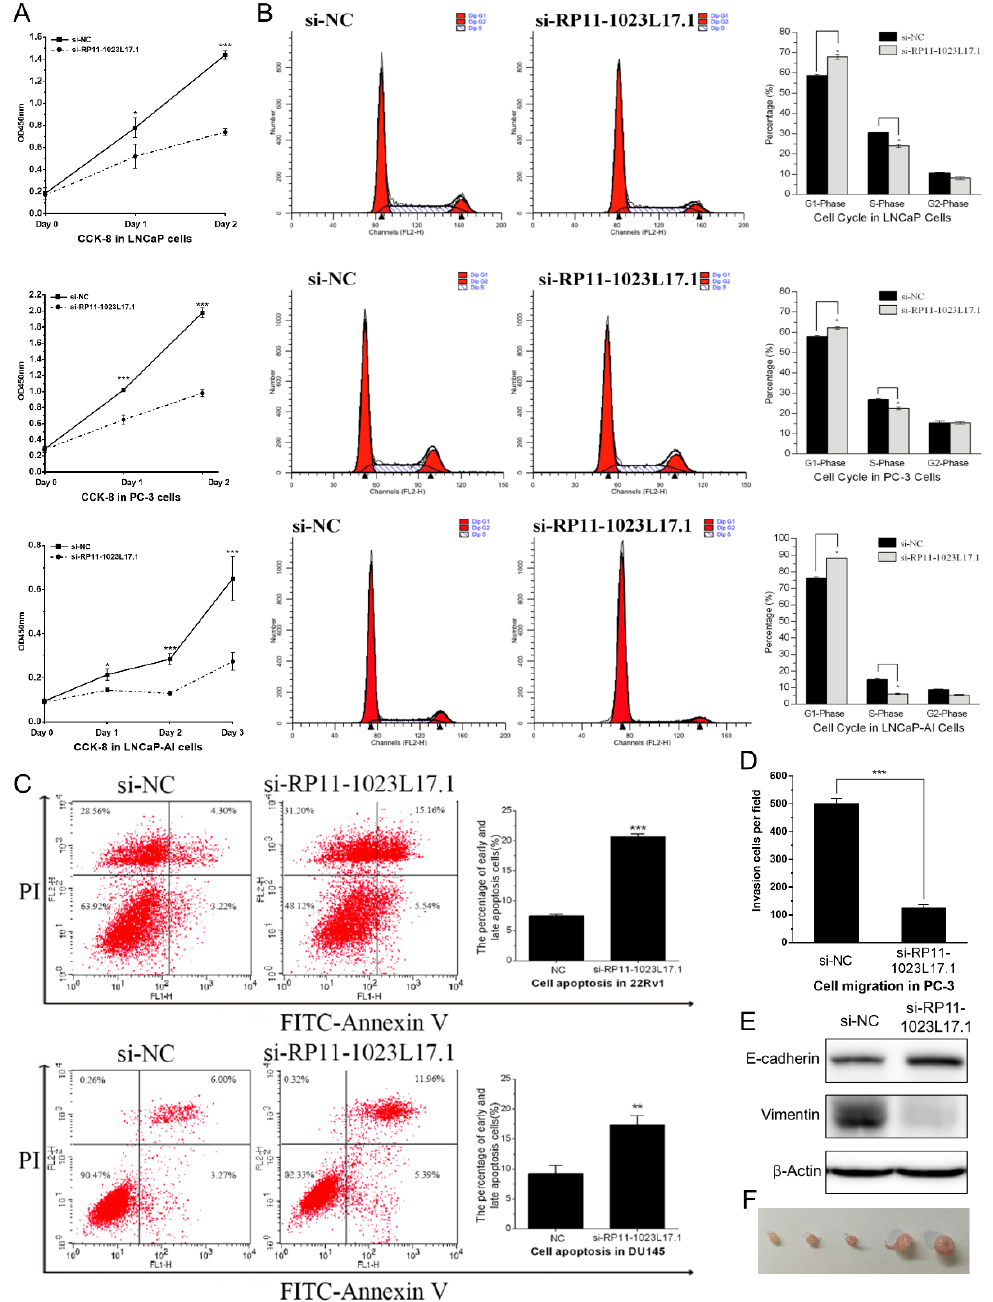
Figure 3. RP11-1023L17.1 promotes proliferation migration, and EMT of PCa cells. ( A ) Cell prolifera- tion was measured by CCK-8 assay of LNCaP, PC-3, and LNCaP-AI cells transfected with si-NC or siRNA targeting RP11-1023L17.1 (si-RP11-1023L17.1). ( B ) The LNCaP, PC-3, and LNCaP-AI cells transfected with si-NC or si-RP11-1023L17.1 were stained with propidium iodide (PI), and the cell cycle distributions were evaluated by flow cytometry. ( C ) The 22Rv1 and DU145 cells transfected with si-NC or siRNA targeting RP11-1023L17.1 were stained with annexin V and PI, and the cell apoptosis was evaluated by flow cytometry. ( D ) Cell migration was monitored by transwell assay in PC-3 cells transfected with si-NC or si-RP11-1023L17.1. ( E ) Assessment of E-cadherin and vimentin expression by Western blotting in PC-3 cells transfected with si-NC or si-RP11-1023L17.1. β -actin was used as a loading control. ( F ) Tumor derived from PC-3 sh-NC cells formation in nude mice after injection. * p < 0.05, ** p < 0.001, and *** p < 0.0001. Data are presented as mean ± SD ( n ≥ 3). Then, we established the RP11-1023L17.1 stable knockdown PC-3 cell line (PC-3-sh- RP11-1023L17.1), and observed that its growth rate was markedly reduced compared with